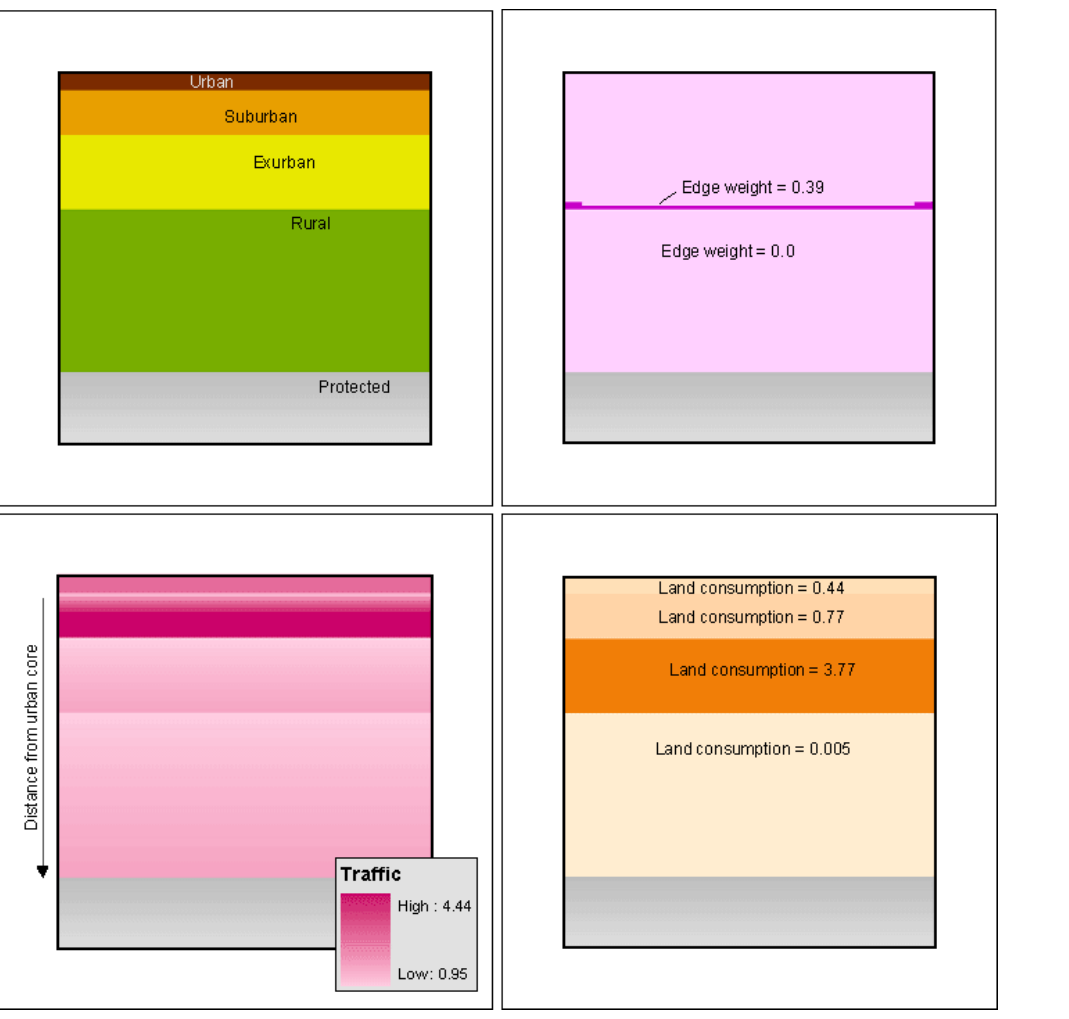
Fig. 2. An illustration of the three components of the Landscape Sprawl (LS) metric. The development pattern (upper left) is based on housing density, classified here to four categories: urban (<0.1 ha per unit) comprises 4% of the area, located at the top, followed by suburban (0.1–0.68 ha per unit; 12%), exurban (0.68 – 16.18 ha per unit; 20%), and rural (>16.18 ha per unit; 44%). Protected land (e.g., public national forest, park, etc.) has no housing density and makes up 20%. LS1–Where rural or protected lands are adjacent to urban, suburban, or exurban densities, an edge contrast weight is computed (upper right). Edges formed by higher density housing lead to a higher edge contrast, and disjoint or “leapfrog” development (>0.5 km) is also penalized by the edge weight. LS2–To get at spatial configuration of development, the distance (square-root transformed) in minutes of travel time along major roads and highways from urban areas is multiplied by housing density to account for the number of trips or vehicle miles traveled (lower right). Within each class, this component increases slightly with increasing distance, but housing density is fairly dominant, so that suburban areas, even though they are closer, account for a greater impact because of the sheer number of housing units. LS3–The inverse of housing density (units per ha) is land consumption (ha per unit). Note that the final LS metric value is the summation of these three